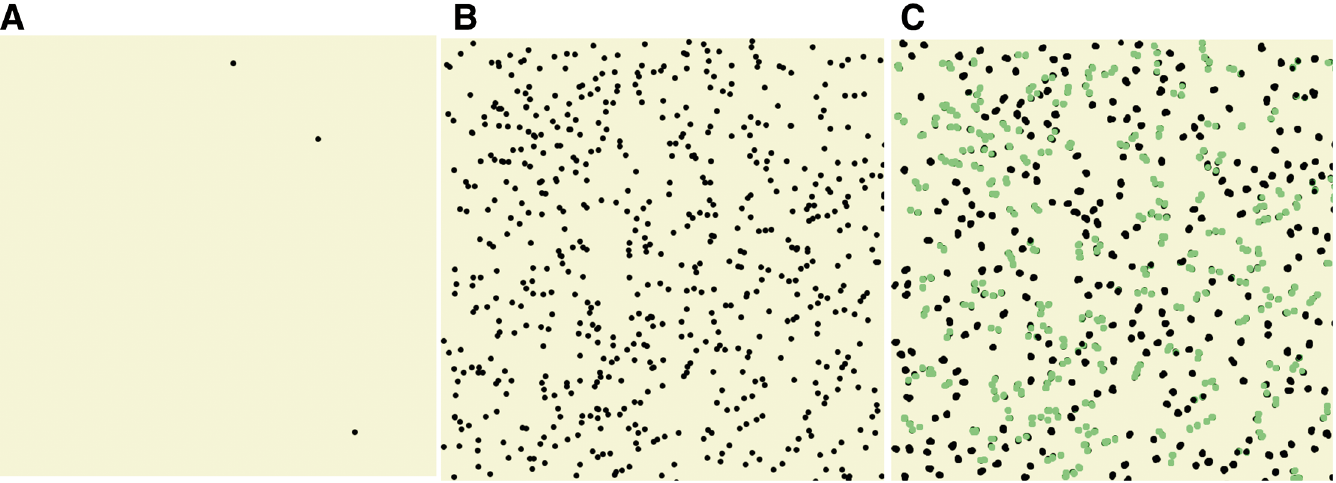
Fig 1. Representation of an “over-head” view of receptor density and associations. Each “dot” represents the radius of gyration of a surface IgE molecule.Panel A; density of 5000/cell.Panel B; density of 500,000/cell. Panel C; density of 500,000/cell where green dots represent IgE-FceRI molecules in close enoughproximityto be considereda potentially functionalaggregatebasedon publishedstudies.